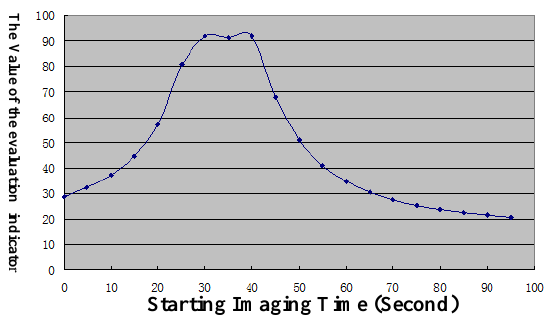
Figure 4. The relation between TS and the indicator of the